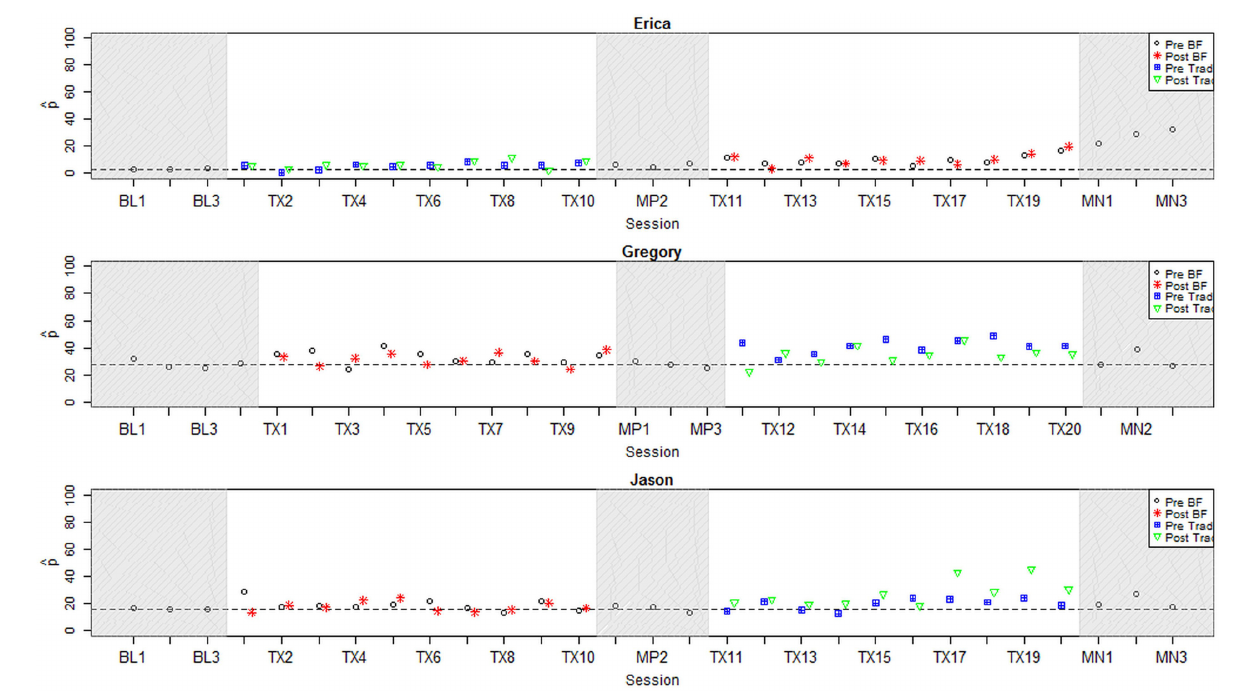
FIGURE 3 | Longitudinal plots of ˆ p correct for participants with small positive effect sizes. Dashed line represents mean across baseline sessions. BL, Baseline; Tx, Treatment; MN, Maintenance; BF, Biofeedback; Trad,